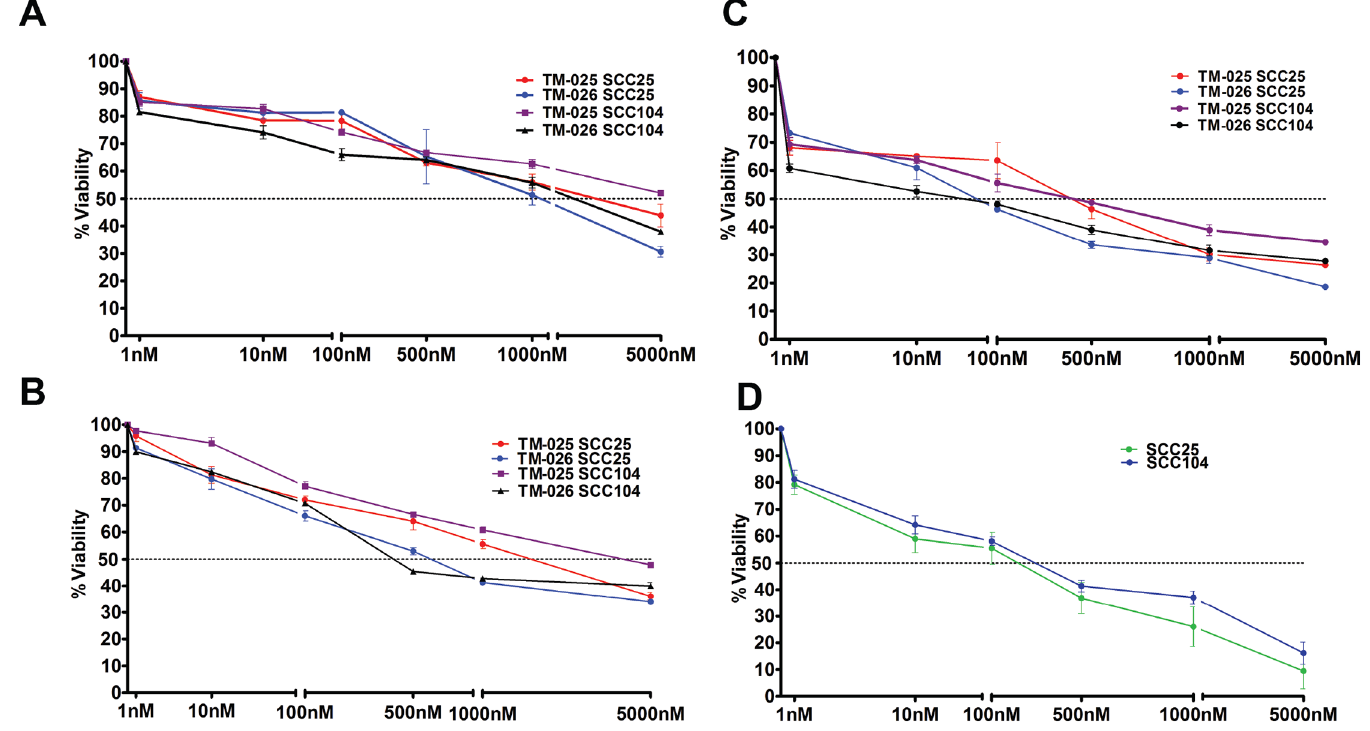
Fig 1. PCT analogs reduced viability of human head and neck cancer cells (SCC25 and SCC104) in a dose-dependent manner. (A-C): 1×10 4 cells of each type were treated with TM-025 and TM-026 for 24, 48 and 72 h (A, B and C, respectively) in increasing concentrations (1, 10, 100, 500, 1000 and 5000 nM). Percentage viability of SCC104 and SCC25 cells (estimated by MTT assay) were significantly (P < 0.05) reduced with higher doses of both analogs. (D): Effect of 48 h treatment of the parent compound PCT in SCC25 and SCC104 cell lines. All experiments have been performed in triplicates, and results obtained have been plotted as the data means ( ±